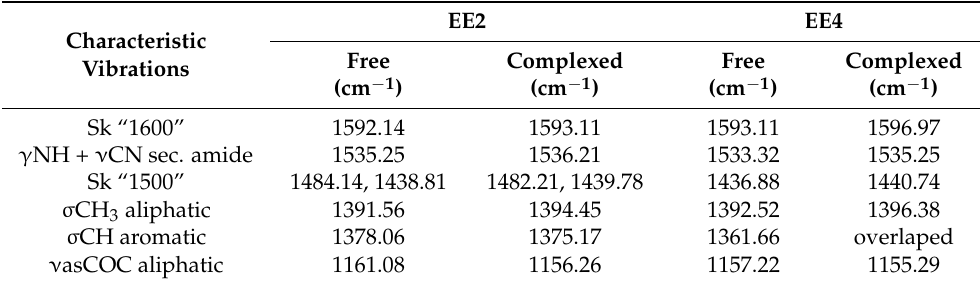
Table 1. Modified characteristic vibrations of ethyl esters after complexation.